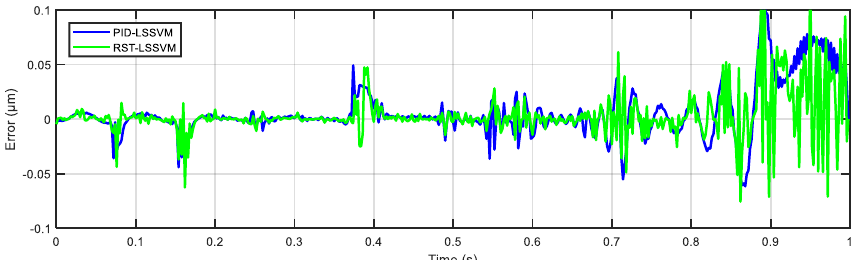
Figure 18. Tracking errors of the RST-LSSVM control scheme compared with the PID-LSSVM control scheme on data E.